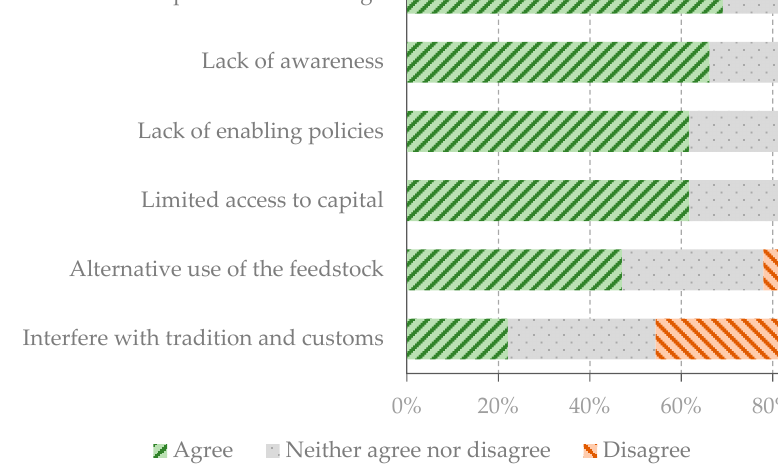
Figure 3. Constraints preventing farmers from engaging in biochar deployment (within the sub- sample of farmers with prior knowledge of biochar, n = 68).